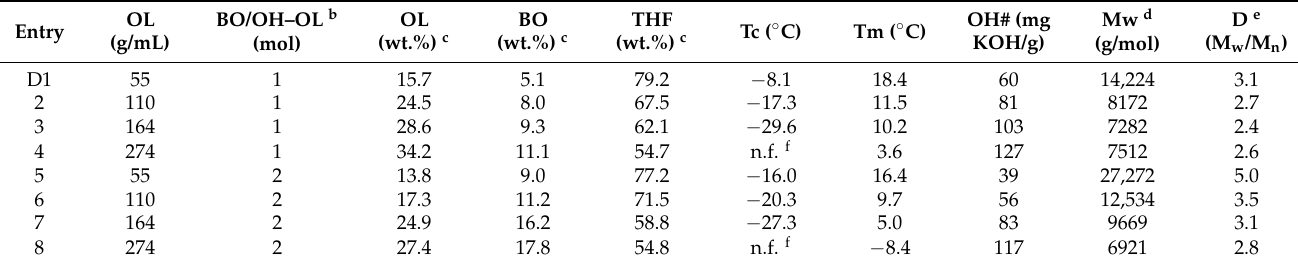
Table 2. Influence of the OL concentration on the LBP microstructure a